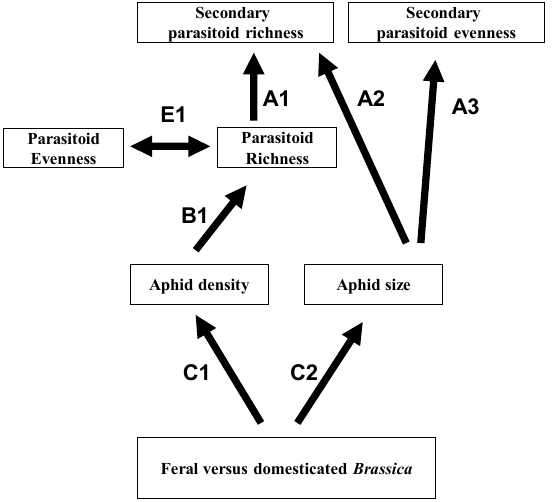
Figure 3. The ecological meltdown demonstrated by Terborgh and colleagues [41] was a strong demonstration of a trophic cascade—tropical islands without vertebrate predators experienced very low productivity, due to outbreaks of herbivores, such as leaf cutter ants. This system could also be reexamined as a diversity cascade, since enemies of herbivores, such as phorid flies, are still present on all islands, and the herbivore and plant communities are diverse webs. Another study on this same system of islands [101] demonstrated that the islands with missing vertebrate predators had herbivore communities dominated by leaf-cutter ants (lower overall evenness of herbivores, B1), while islands with higher richness and abundance of predators had higher evenness in herbivore communities (balanced between howler monkeys and insects). This change in herbivore diversity was associated with lower plant productivity (potentially caused by pathway C1), which was partially responsible for decreases in overall bird diversity (via C2) on the low predation islands.